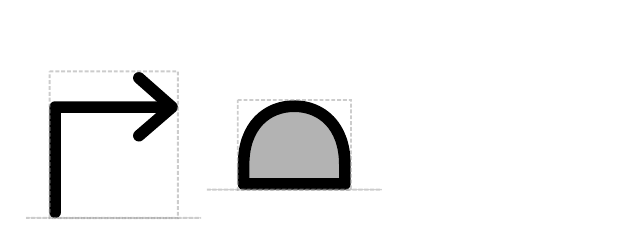
Figure 2: Examples of glyph specification: this specification for the sequence feature glyphs for Promoter (left) and Ribosome Entry Site (right) include the glyph outline, fill (grey center of Ribosome Entry Site), bounding box (dashed box), and recommended alignment with the nucleic acid backbone (dashed horizontal line), all at a preferred relative scale.